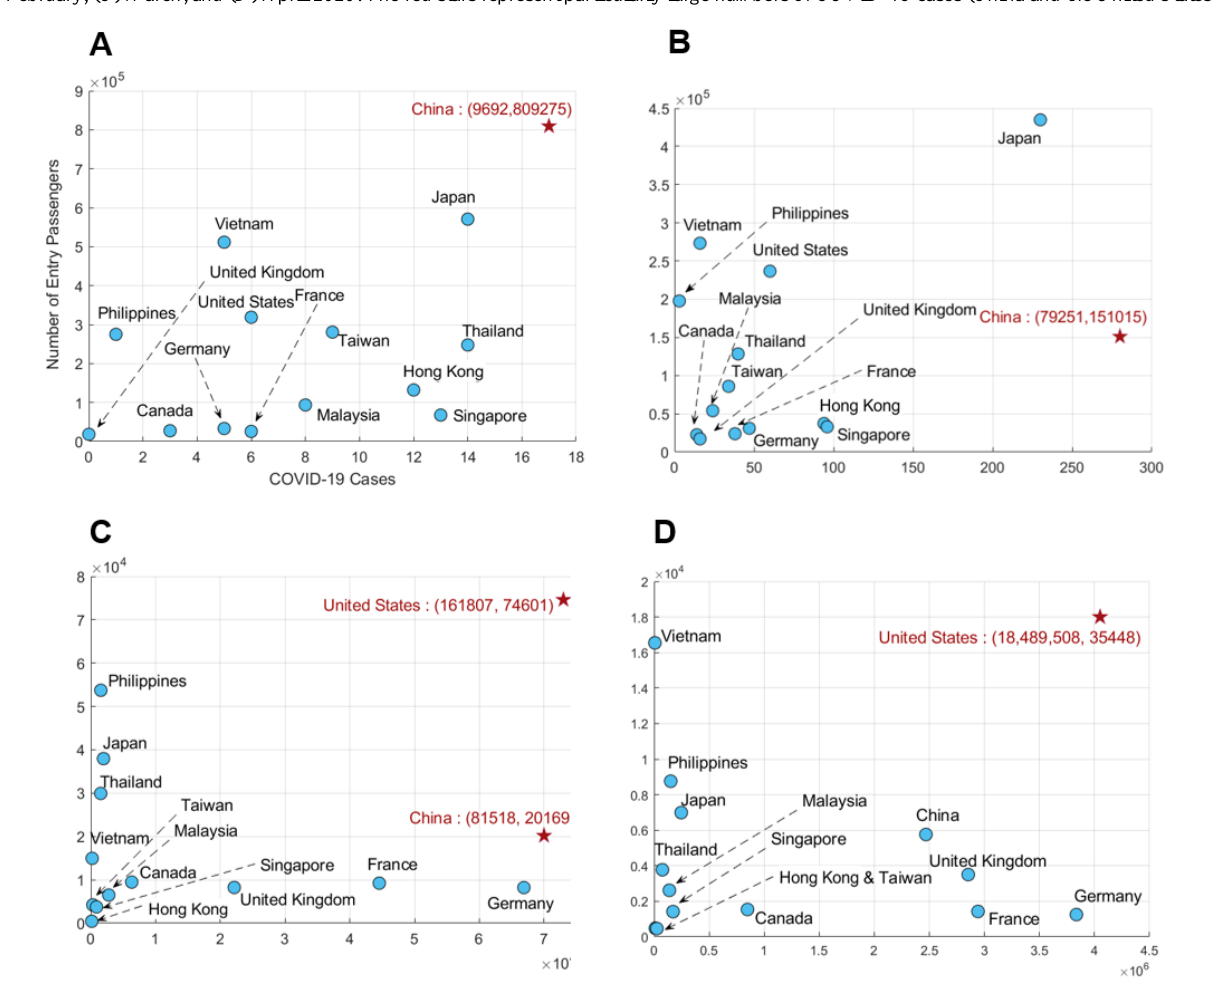
Figure 2. Relationship between the monthly number of passengers entering South Korea and COVID-19 cases at originating countries in (A) January, (B) February, (C) March, and (D) April 2020. The red stars represent particularly large numbers of COVID-19 cases (China and the United